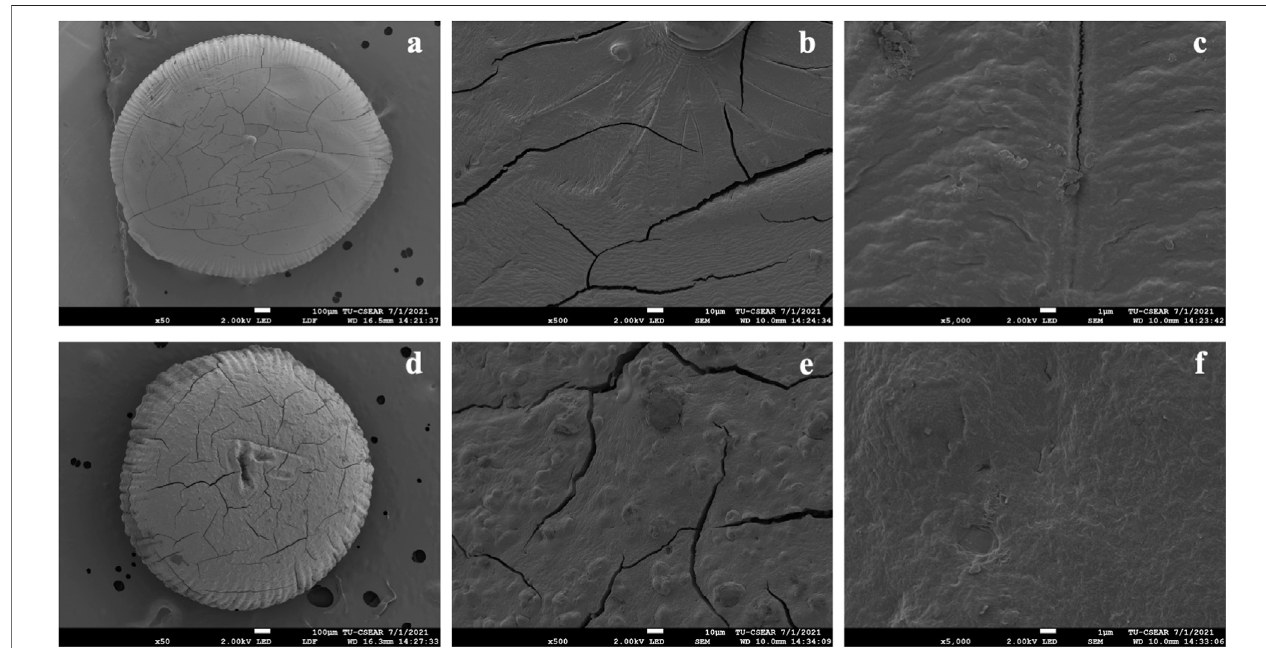
FIGURE4| Scanningelectronmicroscopy(SEM)imagesshowingthesurfacemorphologyofpectin/hi-maizestarchhydrogelbeads. (A) Onlypectinhydrogelbead (magni fi cation × 50), (B) only pectin hydrogel bead (magni fi cation × 500), (C) only pectin hydrogel bead (magni fi cation × 5000), (D) pectin/hi-maize starch hydrogel bead (ratio 4.5:1.5; magni fi cation × 50), (E) pectin/hi-maize starch hydrogel bead (ratio 4.5:1.5; magni fi cation × 500), and (F) pectin/hi-maize starch hydrogel bead (ratio 4.5: 1.5; magni fi cation × 5000).